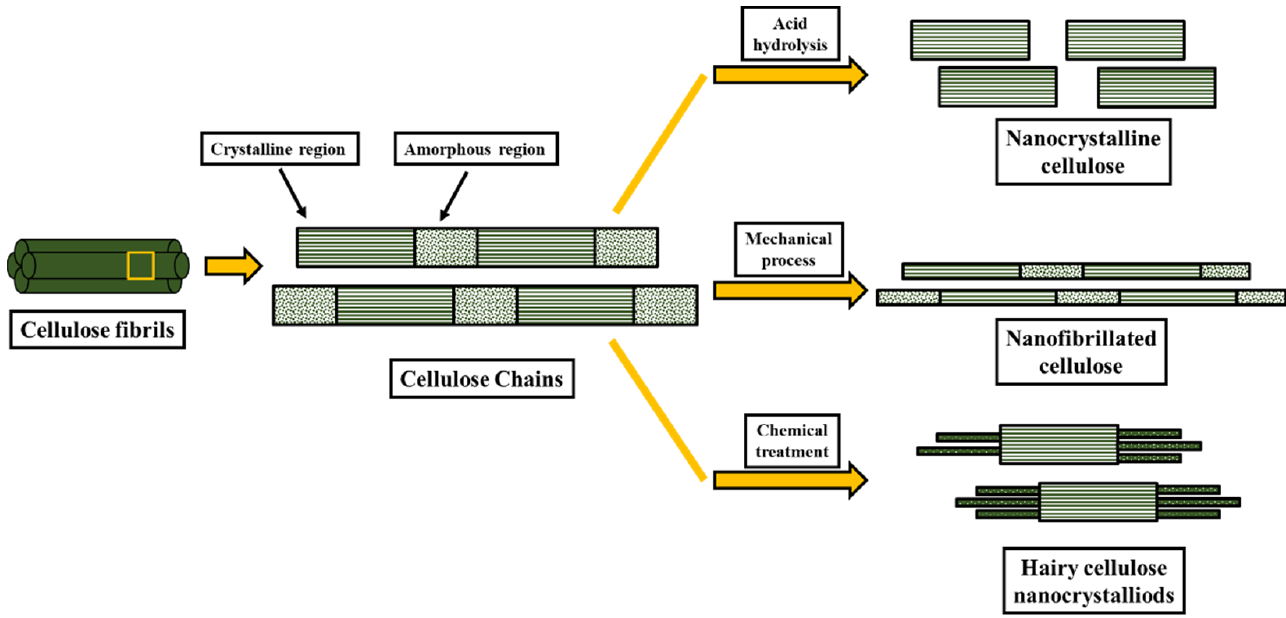
Figure 2. Schematic showing nanocellulose extraction from lignocellulosic biomass.